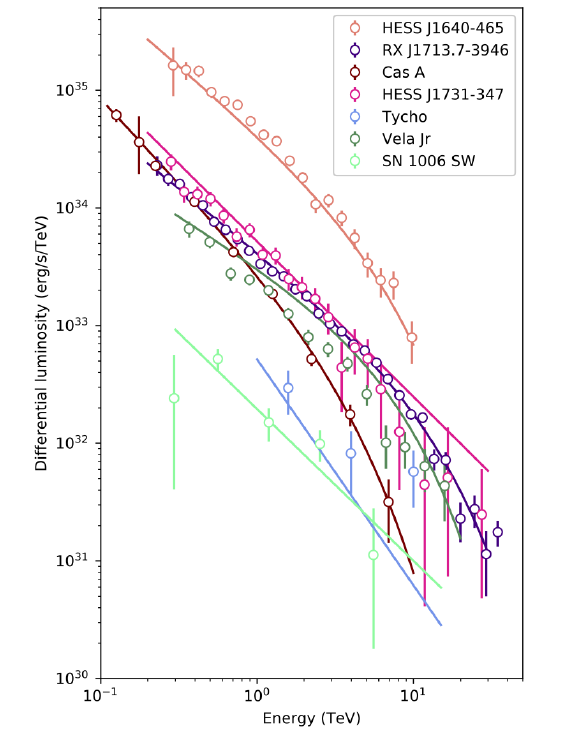
Figure 3. Differential luminosity curves for the some of the most commonly studied SNRs at TeV energies. The spectra show cut-offs at several TeV, which point towards efficient acceleration up to few tens–hundreds of TeV. Figure from